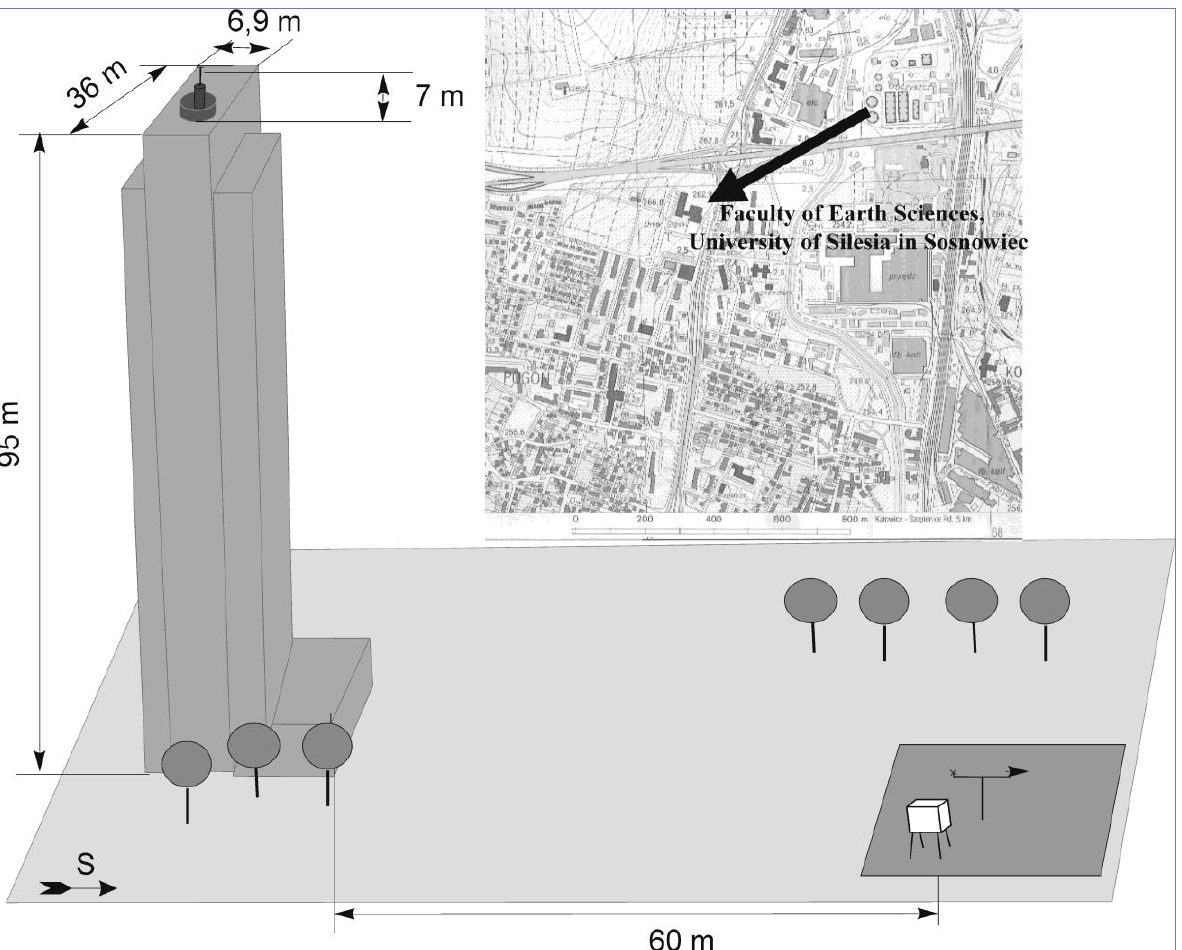
Fig. 2. Localisation of the Faculty of Earth Sciences meteorological stations in Sosnowiec. See text for